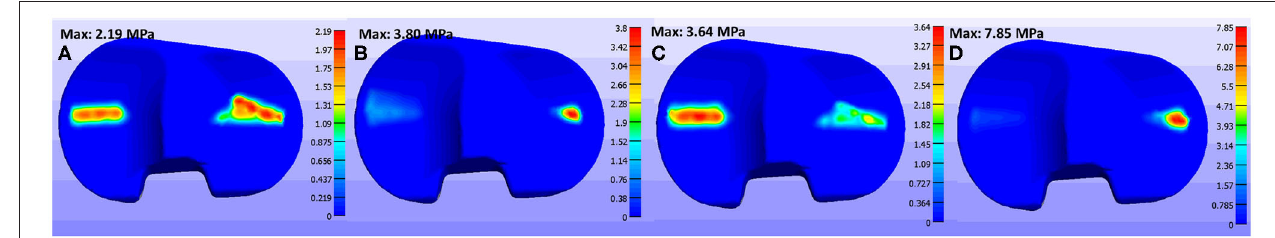
FIGURE 9 | Contact pressure values on tibial insert at (A) smooth gait during 1st axial peak force, (B) smooth gait during 2nd axial peak force, (C) bouncy gait during 1st peak force, and (D) bouncy gait during 2nd axial peak